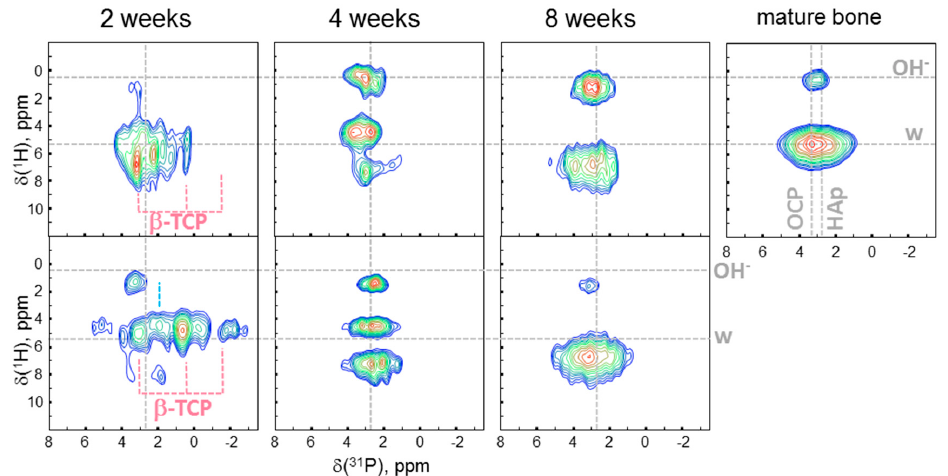
Figure 3. 1 H- 31 P heteronuclear correlation (HETCOR) spectra of the newly formed tissues after two, four, and eight weeks of healing time and of mature bone. For each healing period samples from two animals (top and bottom) were measured. Guidelines at the 1 H chemical shifts of 0.2 ppm and 5.4 ppm characteristic of apatitic hydroxides and water, respectively, are shown. In the 31 P direction, the guideline at 2.7 ppm characteristic of hydroxyapatite is indicated in all samples. In addition, in the spectrum of mature bone, the guideline at 3.3 ppm, characteristic of octacalcium phosphate (OCP), is shown.